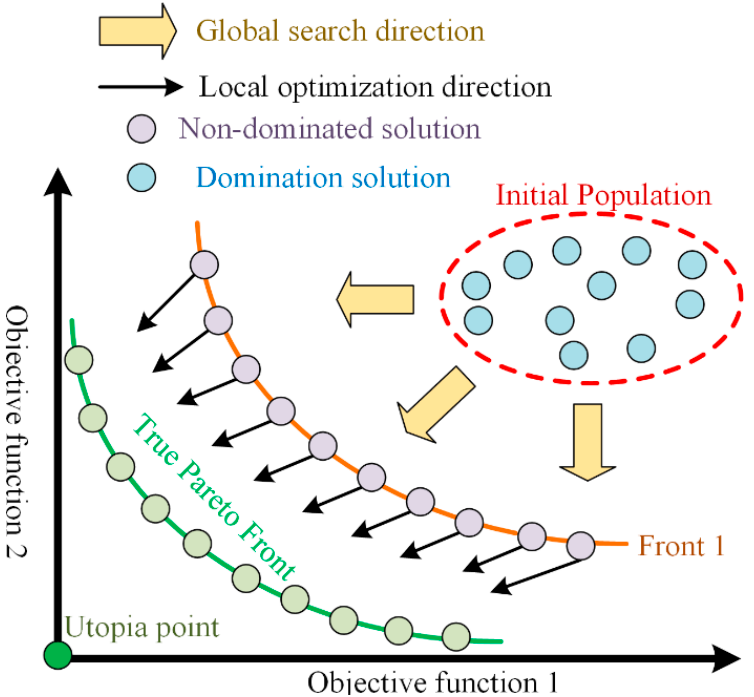
Figure 3. A schematic of how the Pareto front results in the optimal solution of two objective func- tions.